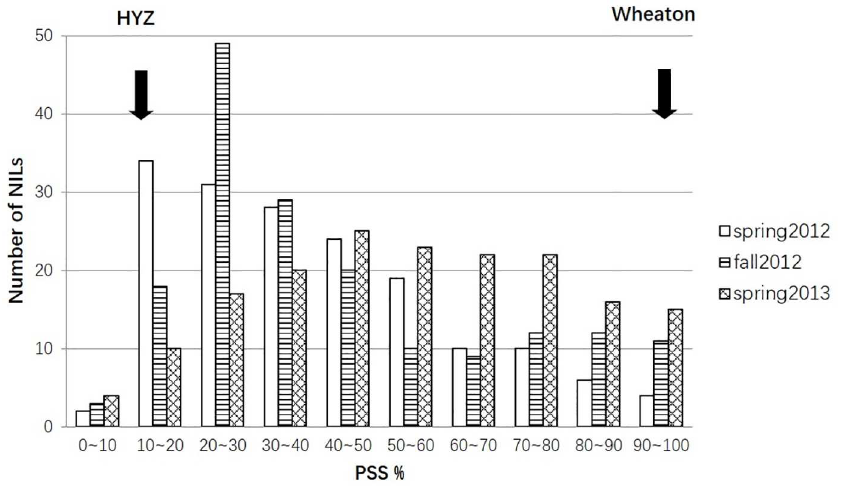
Fig 1. Frequency distribution of mean percentage of symptomatic spikelets in a spike (PSS) for the recombinant inbred line (RIL) population derived from ‘Haiyanzhong’ (HYZ) x ‘Wheaton’ evaluated in spring and fall 2012, and spring 2013 greenhouse